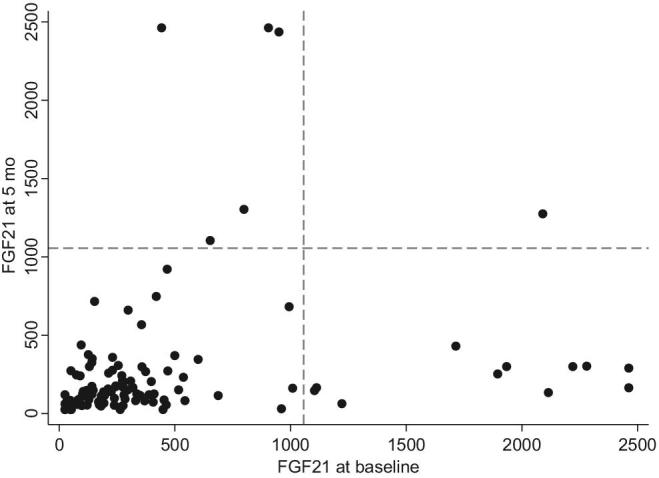
Scatterplot of plasma FGF21 concentrations at enrollment and after supplementation. Dashed line indicates the 90th percentile of baseline values (1056.5 pg/mL). FGF21, Fibroblast Growth Factor 21.